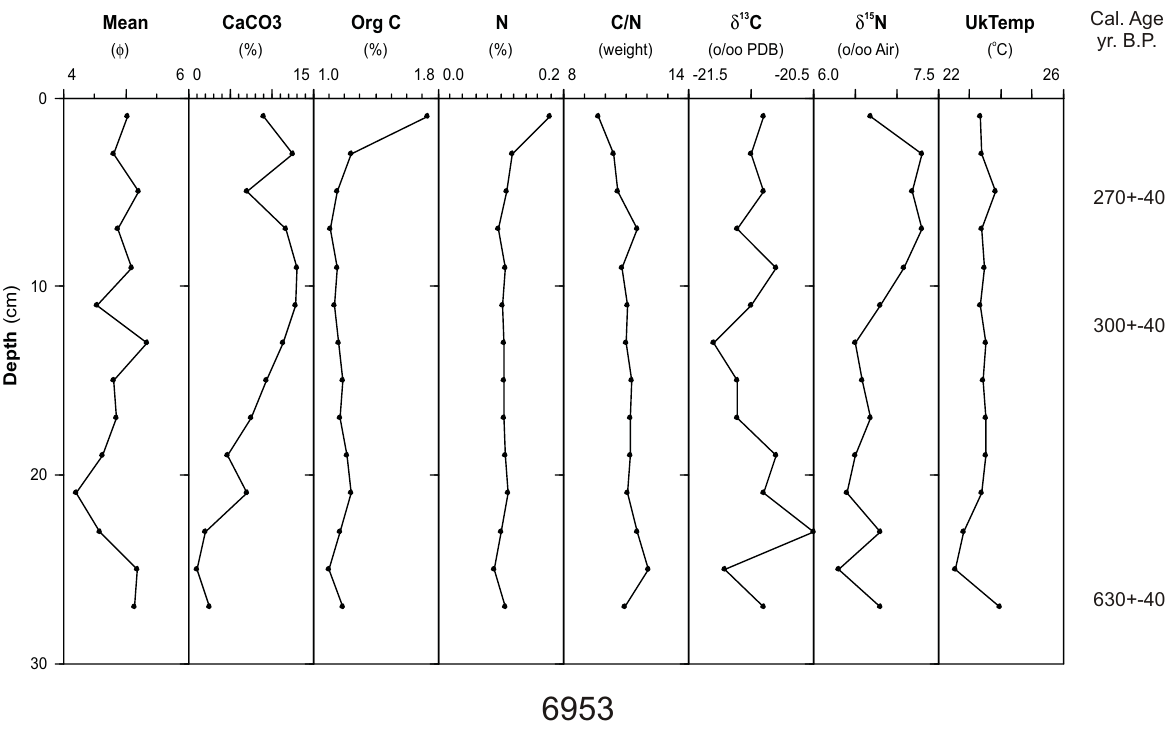
Fig. 6 – Mean grain-size, compositional, isotopic, and paleotemperature variations along core 6953.